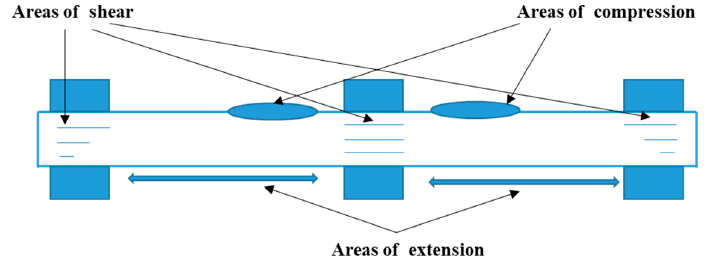
Figure 4. Schematic diagram of flexure test fixtures.